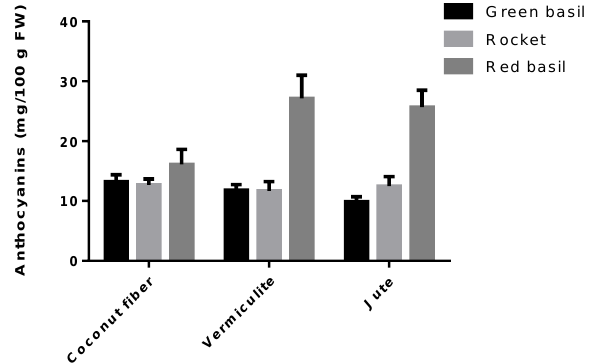
Figure 10. Anthocyanin concentrations of green basil, rocket, and red basil microgreens grown on three different substrates. Values, subjected to two-way ANOVA, are means ± SE (n = 6).